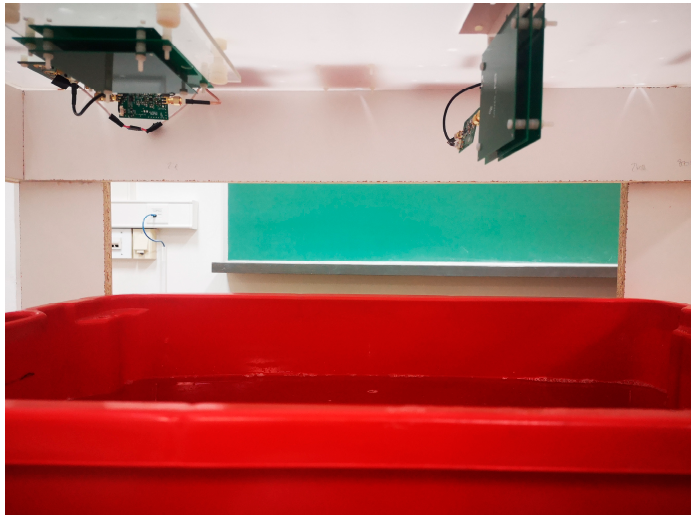
Figure 12. The photograph of the sensor above the container filled with saline water.